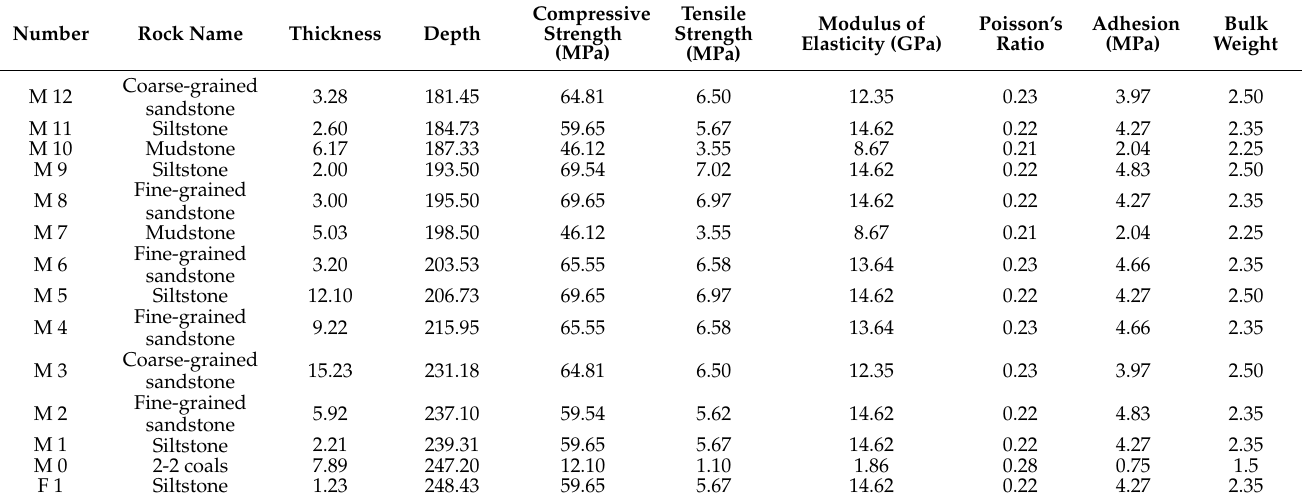
Table 1. JB22 brief list of petrophysical and mechanical properties of drilled coal seams and their overburdens.